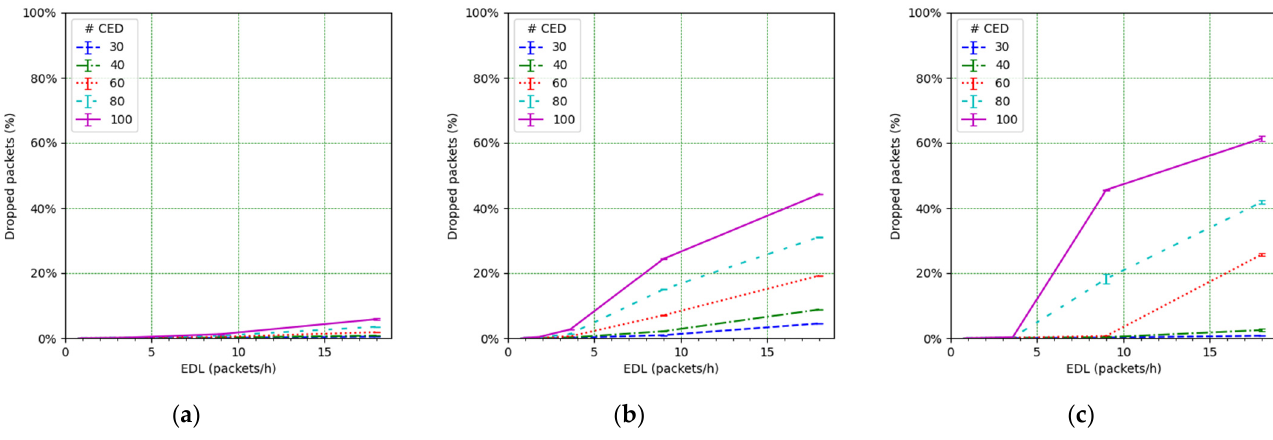
Figure 16. Packet losses due to duty cycle restrictions at the EDs vs. EDL for ( a ) SFM1, ( b ) SFM2, and ( c ) SFM3.